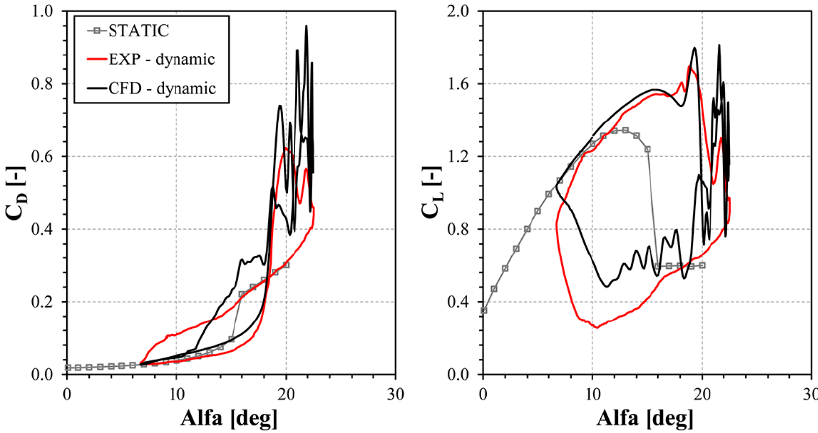
Figure 11. Comparison experimental results and CFD computations for dynamically changed angle of attack.